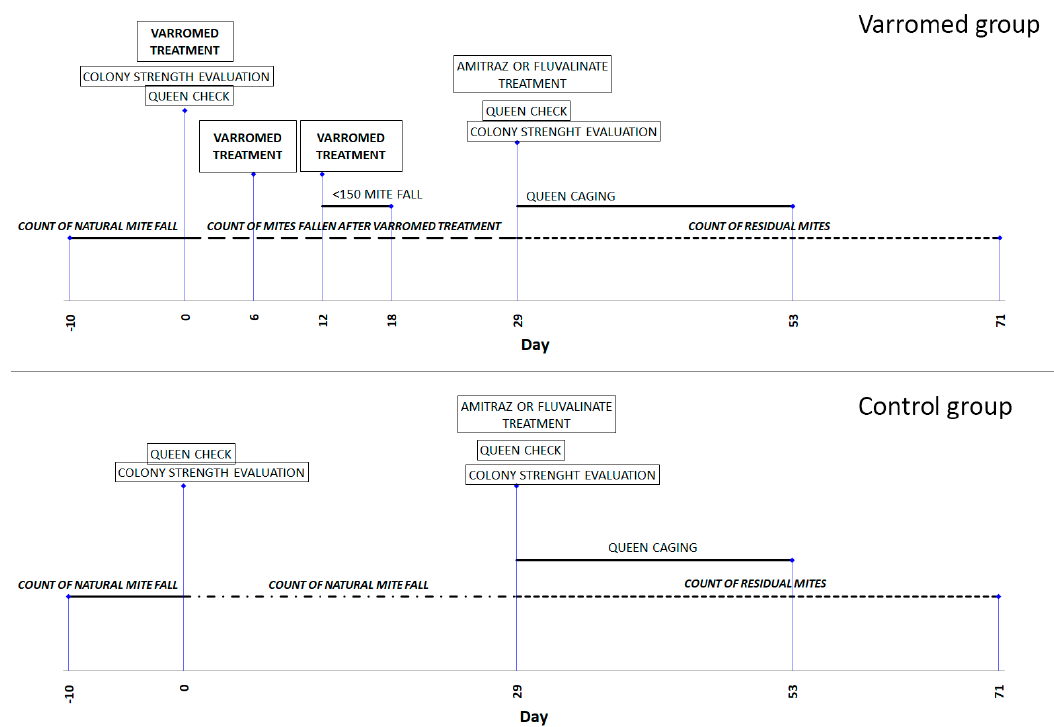
Figure 2. Summer/autumn protocol for the treated group (three repeated treatments) and control group. Only three treatments are needed, if less than 150 mites are detected on the sticky boards.